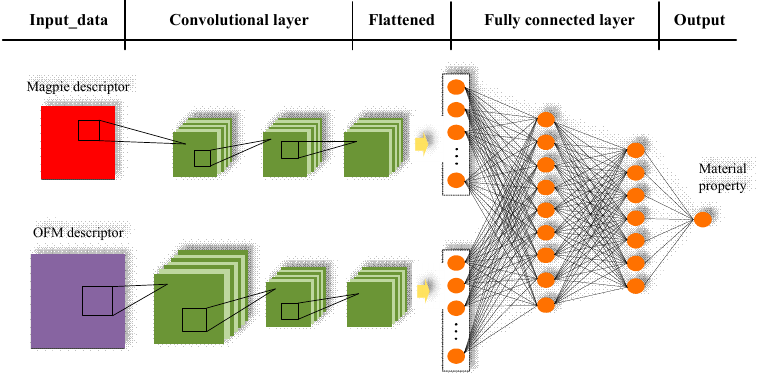
Figure 5. Architecture of the hybrid convolutional neural network with multiple descriptors.